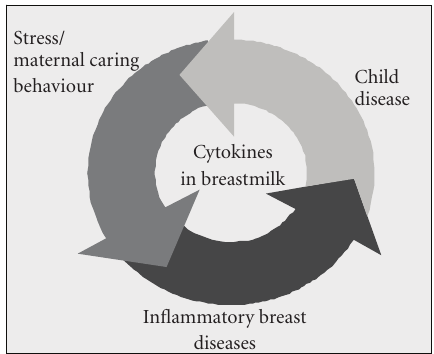
Figure 1: Vicious cycle of increased maternal stress perception, inflammatory breast diseases, and diseases of the newborn trans- mitted by changes in the cytokine pattern in breast